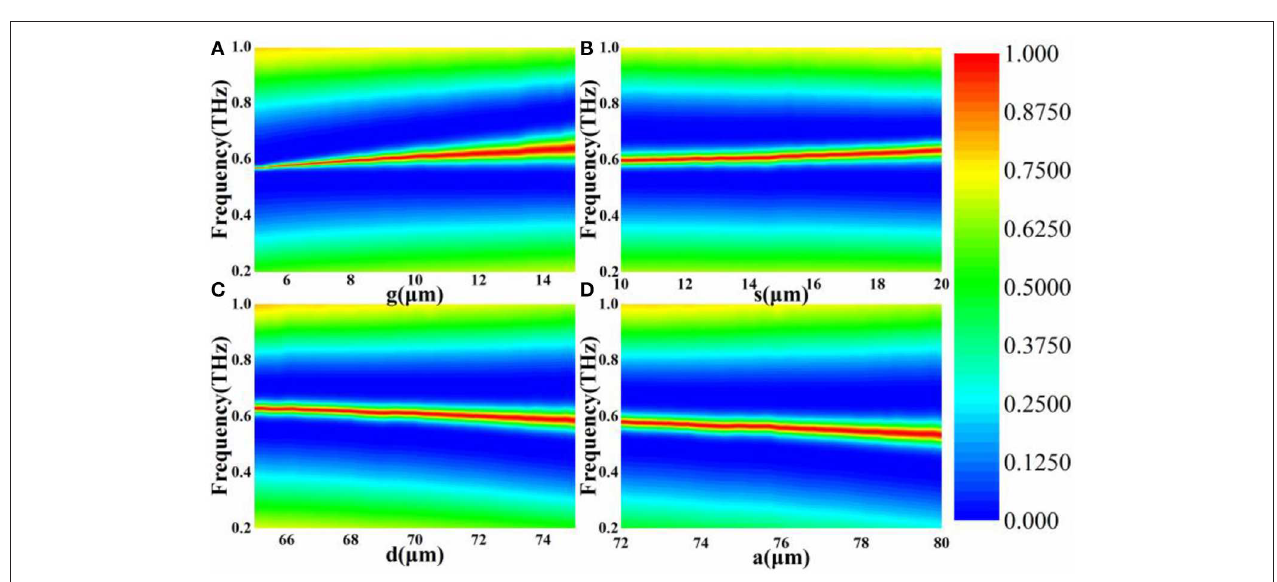
FIGURE 2 | Terahertz transmission spectra of the different parts of the proposed metasurface unit cell.